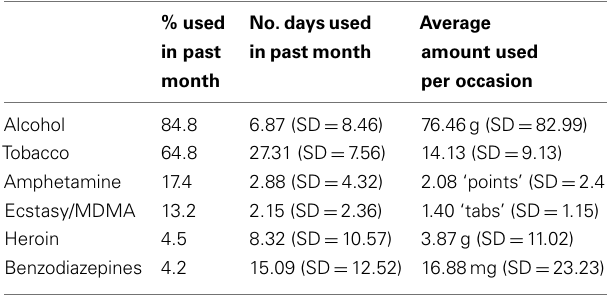
Table 1 | Past month alcohol and other drug use ( N =